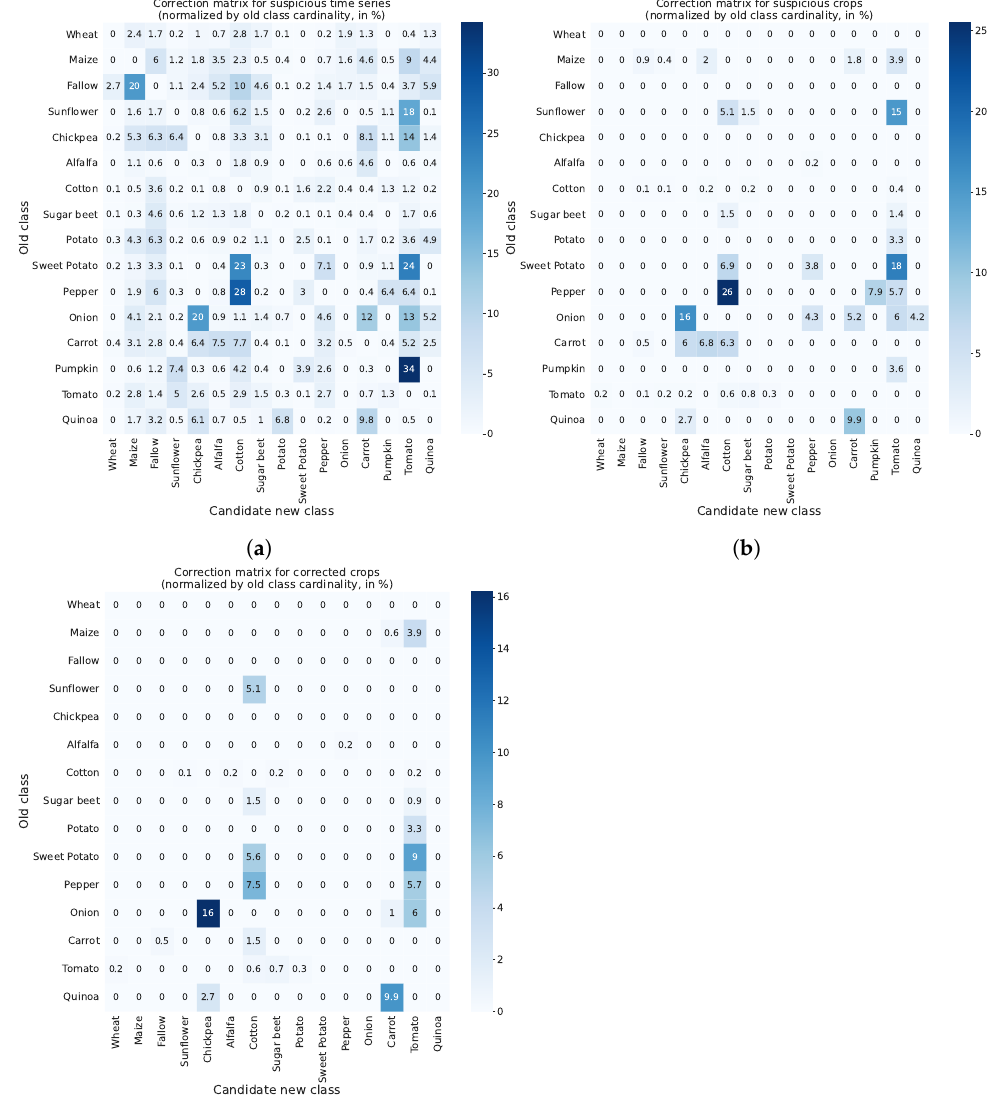
Correction matrix for corrected crops (normalized by old class cardinality, in %)